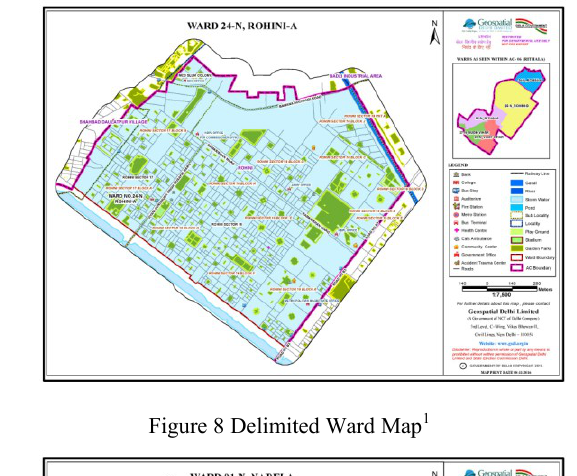
Figure 8 Delimited Ward Map 1